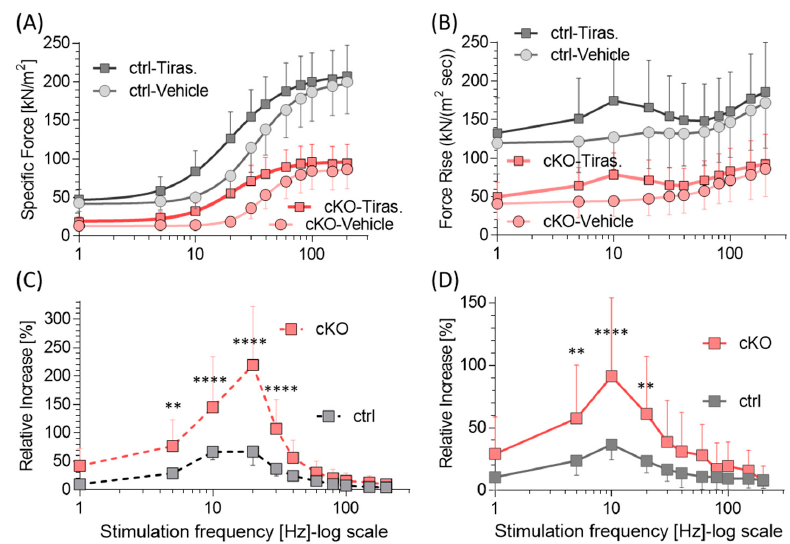
Figure 2. Effect of tirasemtiv on force production in control (ctrl) and Neb cKO diaphragm muscle strips. ( A and B ) Force–frequency curves ( A ) and maximal speed of specific force rise (dF / dt) ( B ) in ctrl and cKO muscle with vehicle or tirasemtiv . Two-way ANOVA with repeated measures reveals in both genotypes that tirasemtiv significantly ( p < 0.0001) affects specific force. Post-hoc tests (Sidak) corrected for multiple comparisons reveal that tirasemtiv increases force at all stimulation frequencies except 1 Hz and maximal force rise at all stimulation frequencies, except 200 Hz for cKO ( p < 0.01). ( C and D ) Effect of tirasemtiv on force ( C ) and speed of force rise ( D ) over vehicle at various stimulation frequencies. In both ctrl and cKO diaphragms, tirasemtiv increases force ( C ) and speed of force rise ( D ) with a maximal effect at ~20 Hz. A standard two-way ANOVA reveals that tirasemtiv has a significantly ( p < 0.0001) different effect on force in Neb cKO diaphragm strips than in ctrl strips. Post-hoc tests (Sidak) corrected for multiple comparisons reveals that Neb cKO muscle has significantly greater enhancement with tirasemtiv than ctrl muscle in the mid-frequency range (** p < 0.01, **** p < 0.0001). (Results from 15 ctrl and 18 cKO mice. Mean ± SD are shown. Note that at several frequencies SD lines fall within the symbols.).